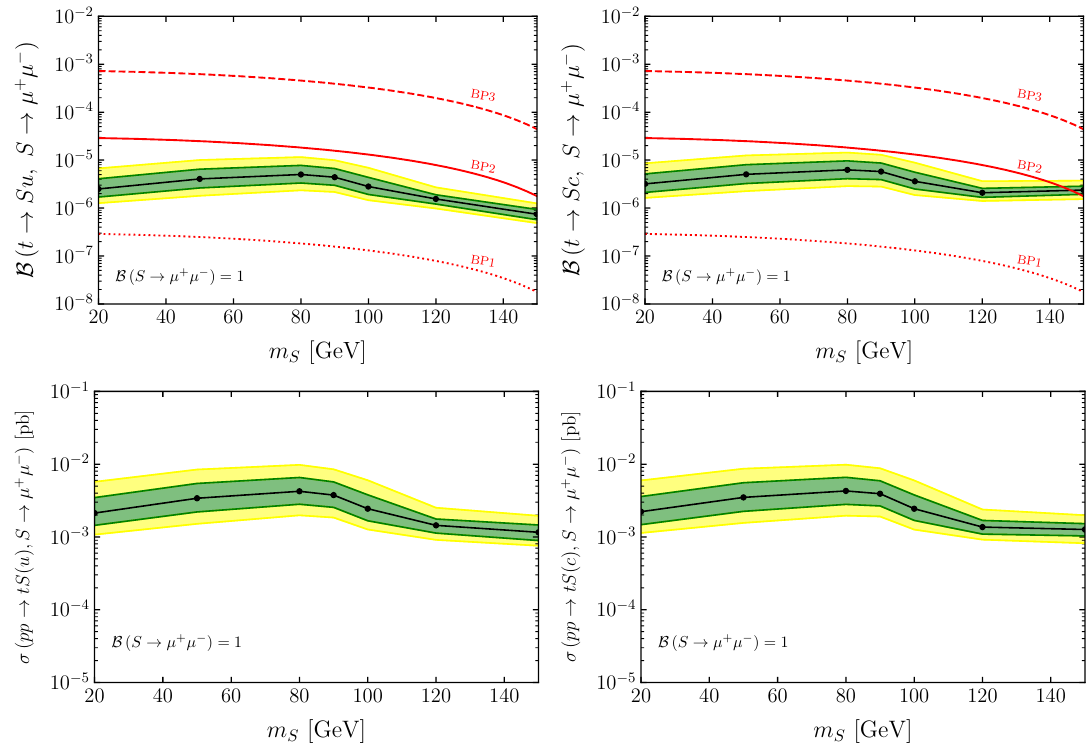
Figure 4 . In the upper (bottom) panels, we show the 95% CL limits on the branching ratio (cross section times branching ratio) that can be tested in the (cid:22) + (cid:22) (cid:0) channel, in the analysis proposed for t ! Sq; S ! (cid:22) + (cid:22) (cid:0) , with q = u ( c ) in the panels on the left (right). The limits are obtained for a collected luminosity L = 150 fb (cid:0) 1 . The green and yellow bands show the (cid:6) 1 (cid:27) and (cid:6) 2 (cid:27) uncertainty on the limits, respectively. Superimposed are the theoretical expectations in three